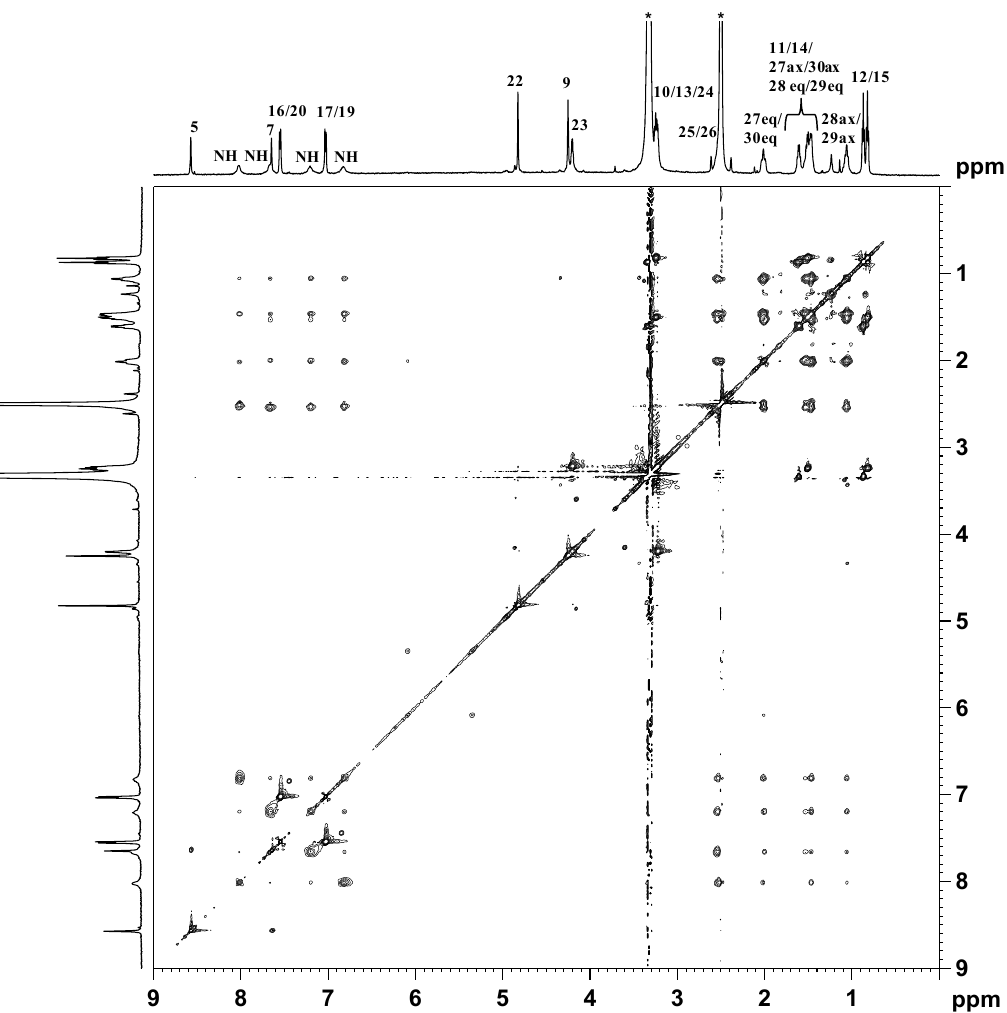
Figure 4. 1 H ( top and left ) and TOCSY 2D ( center ) NMR spectra (600 MHz, 1 H) of 3 in DMSO- d 6 . The asterisks indicate residual solvent peaks.